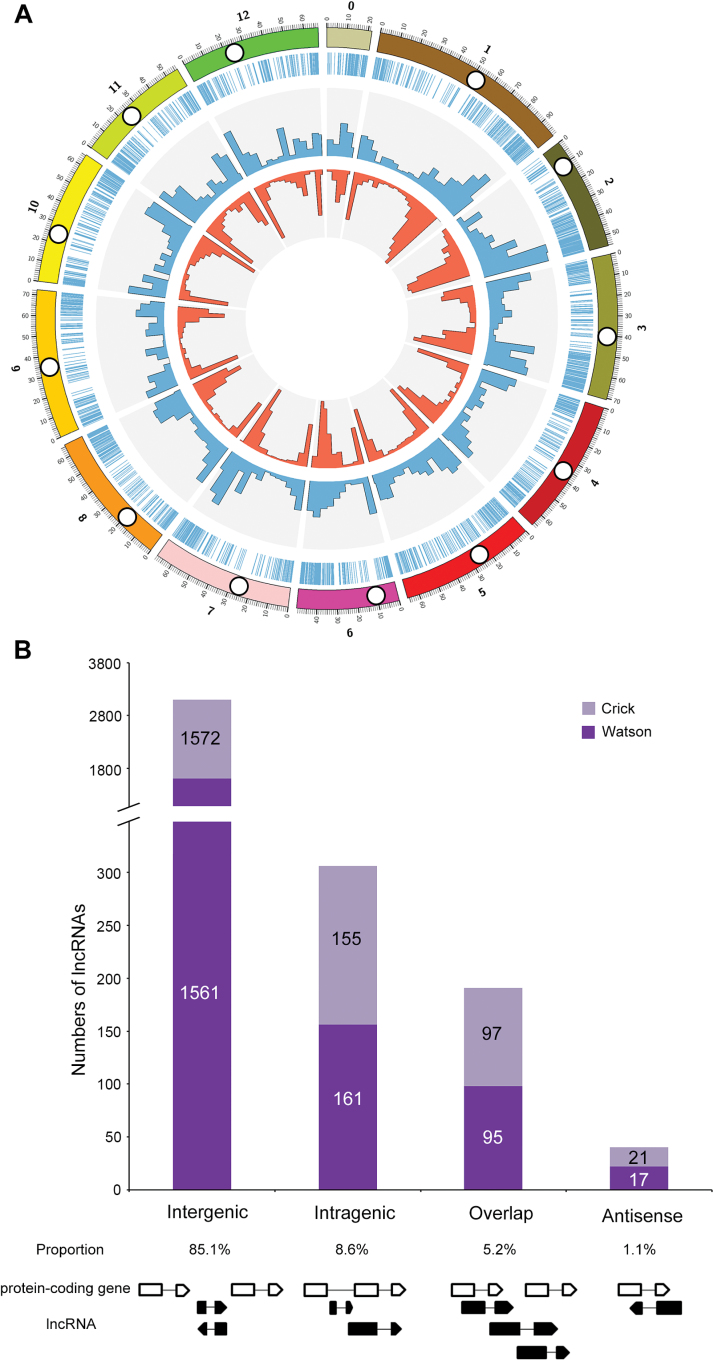
Distribution and classification of 3679 tomato lncRNAs. (A) Genome-wide distribution of tomato lncRNAs compared with that of protein-coding genes. Chromosomes 0–12 (SL2.50 genome) are shown with different colours and in a circular form as the outer thick track. The inner chromosome scale (Mb) is labelled on each chromosome. White circles show approximate centromere locations. On the second track (outer to inner), each vertical blue line reports the location of lncRNAs throughout the whole tomato genome. For the next two tracks, the abundance of lncRNAs and protein-coding genes in physical bins of 10Mb for each chromosome are shown by blue and red columns, respectively. (B) Classification of tomato lncRNAs according to its genomic position and overlap with protein-coding genes. Numbers of lncRNAs in the Watson or Crick strand for each of the four main classes were labelled on the columns (intergenic, intragenic, overlap, and antisense lncRNAs). The proportion of the four kinds of lncRNAs was calculated. A scheme of the position of the lncRNA (black box) relative to neighbouring genes (black empty box) is shown at the bottom.